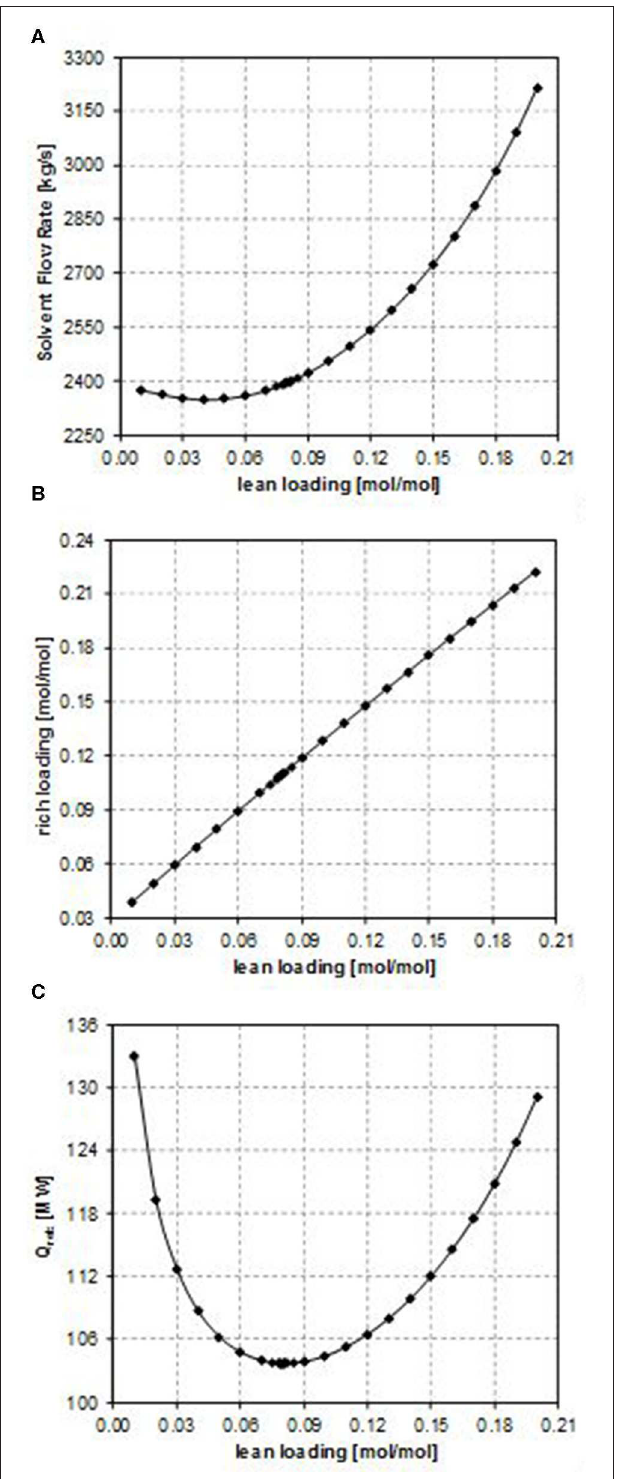
FIGURE 4 | Effect of the CO 2 lean loading on (A) the solvent flow rate, (B) the rich loading, and (C) the reboiler duty ( case G ).